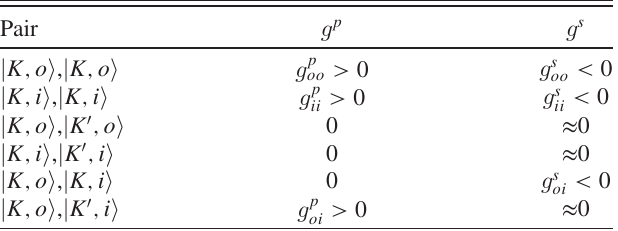
TABLE II. Sign of the pairing interaction that involves either phonons g p or ferromagnetic spin fluctuations g s between two states on the outer and/or inner contour at K and K 0 . The states involved in pairing are denoted as j k ; ν i , where k is a state either at K or K 0 and ν can take on an index o or i to denote a state on the outer ( o ) or inner ( i ) contour. The pseudospin ( ↑ or ↓ ) associated with states on each contour is depicted schematically in Fig. 6. Attractive pairing interactions are positive and repulsive inter- actions are